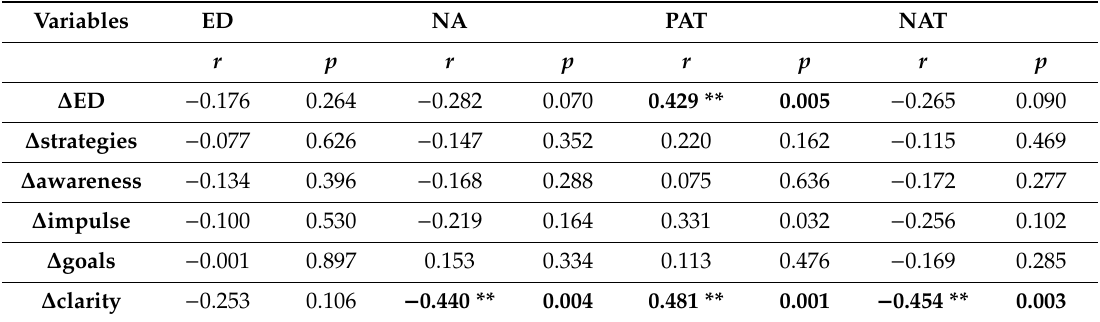
Table 13. Correlations between variables (Pearson’s coe ffi cients): ∆ / ED; ∆ / NA; breast cancer